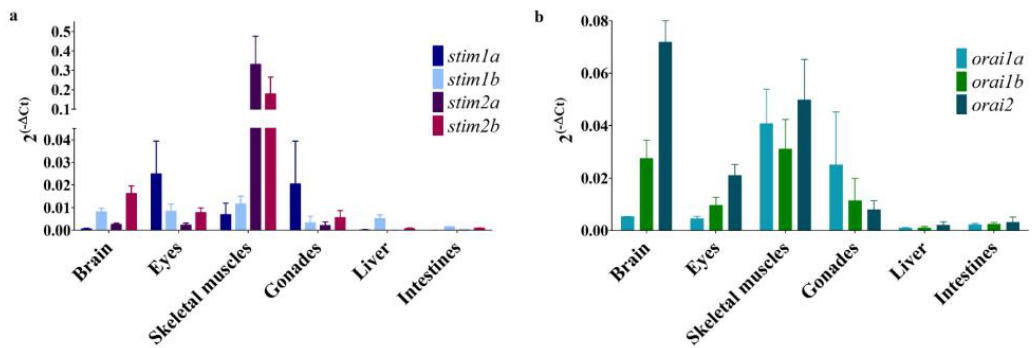
Figure 4. The mRNA levels of stim s ( a ) and orai s ( b ) in various tissues in 8-month-old zebrafish, estimated by RT-PCR: The data are presented as expression levels ± SD, calculated as 2 ( − ∆ Cq) normalized to eef1a1l1 ( n = 3 – 4).